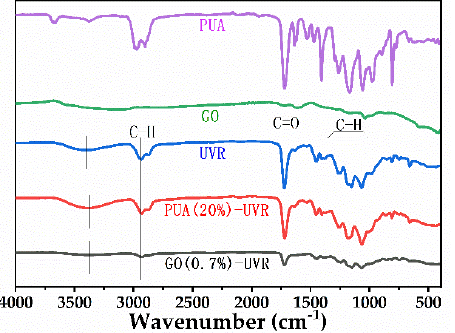
Figure 1. FTIR spectra of free − radical/cationic hybrid (UVR), polyurethane acrylates (PUA, 20%) and graphene oxide (GO, 0.7%) modified hybrid UV cured resins, PUA, and GO.